Question: Looking at the figure, what chart type is it?
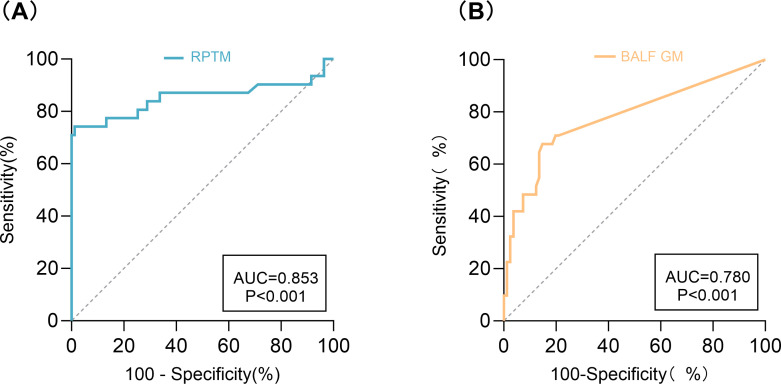
Answer: line